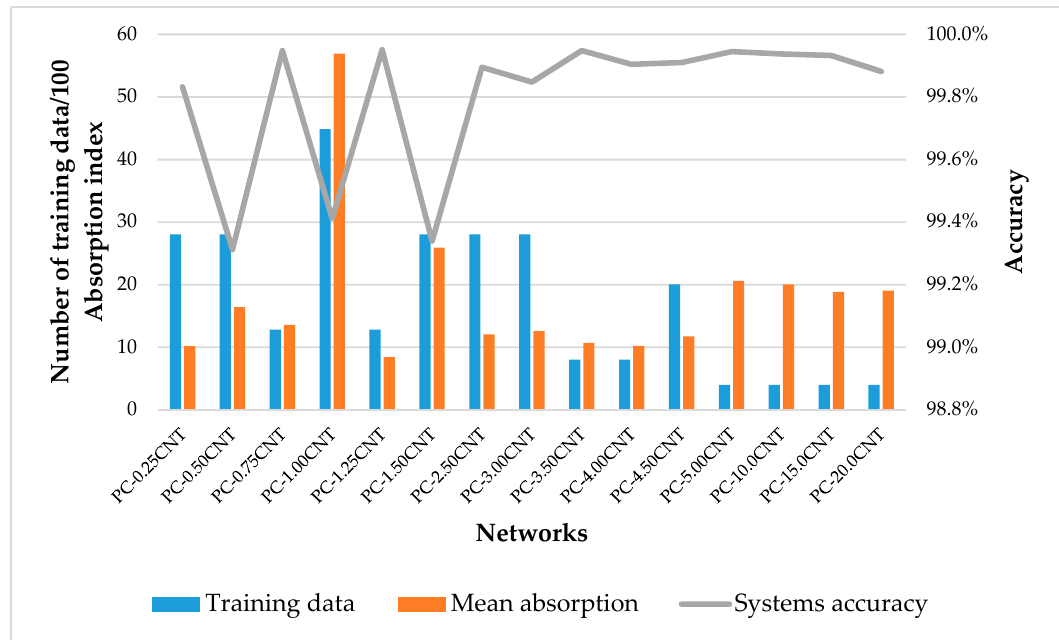
Figure 5. Relationship between training data, the mean absorption index from Table 1, and systems accuracy.